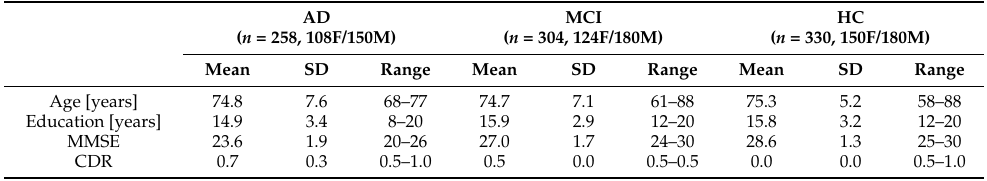
Table 1. Summary of clinical subject demographics and dementia status.